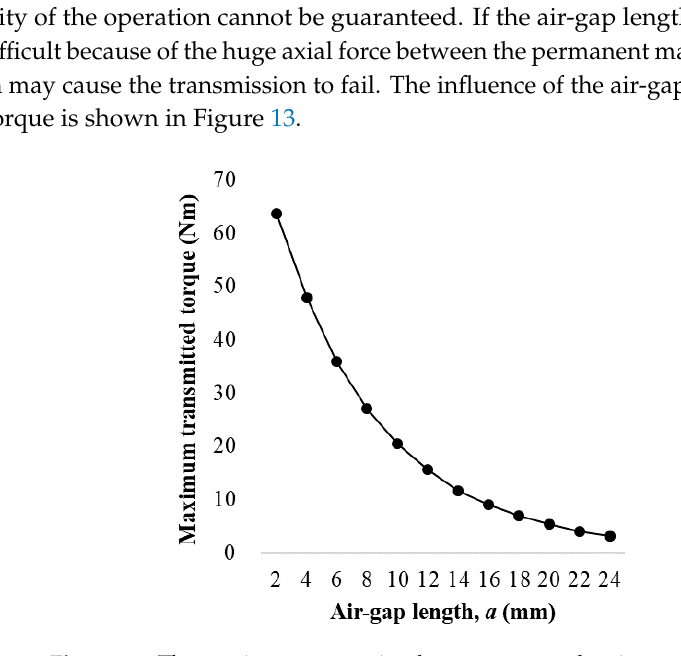
Figure 13. The maximum transmitted torque versus the air-gap length.